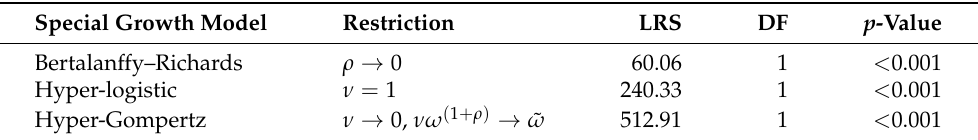
Table notes: LRS, likelihood ratio statistic; DF, Degrees of freedom; ˜ ω stands for a positive constant; see Equation (1) for details on the parameters ν , ρ and ω . The deviance based χ 2 test for overall goodness-of-fit (Table 4) indicates a lack-of- = 11.60%. fit ( p -value < 0.001), with an overall adjusted-deviance reduction ratio of r 2 dev Looking for the sub-models, we noticed that the estimated growth curve is significantly different from the corresponding null model fit ( p -value < 0.001) and does not lack fit = 95.26% (the ( p -value = 0.6115). Indeed, the adjusted-deviance reduction ratio is r 2 dev = 99.96%). The overall lack of fit is due to the adjusted-coefficient of determination is r 2 a